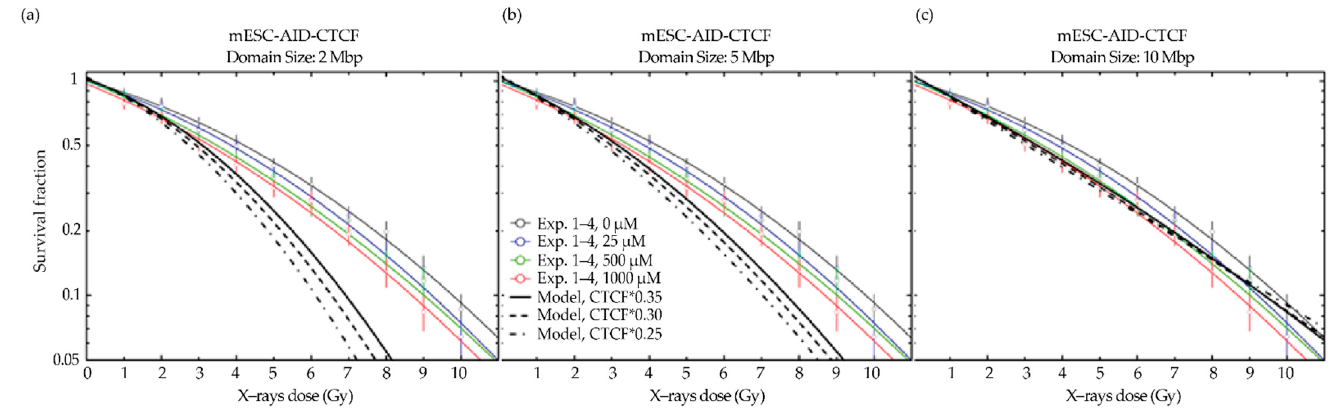
Figure 9. GLOBLE predictions of clonogenic survival upon different levels of auxin-induced CTCF depletion in mESC-AID-CTCF cells, in comparison to the experimental data. The reference condition (0 µ M auxin) is depicted as a full thin black curve. Bold dashed black lines indicate the model predictions for the experimentally determined CTCF depletion levels, whose experimental data from four biological replicates is shown as colored fit lines (curve fit weighted by 1 ) and dots (mean) for comparison (whiskers = error bars). ( a ) Predictions modeled based on the standard 2 Mbp domain size. ( b , c ) Predictions modeled based on a domain size of 5 ( b ) and 10 Mbp ( c ).